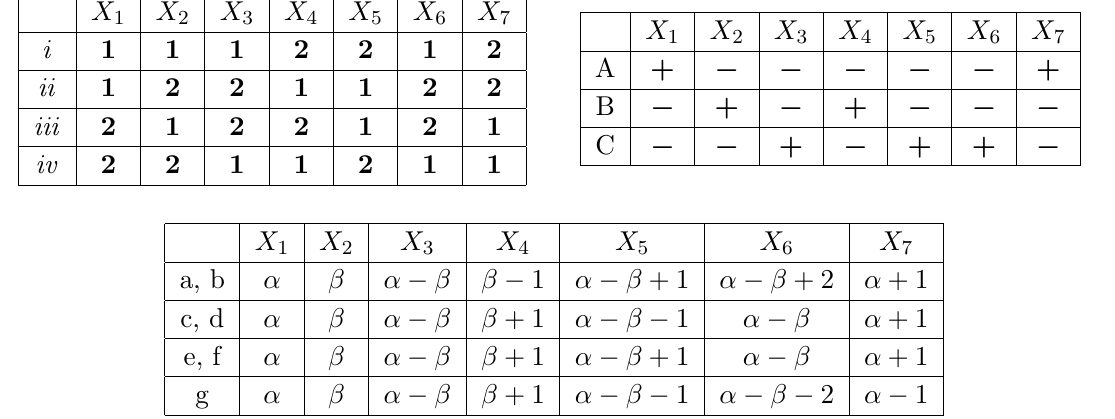
Table 9. SU ( 2 ) L (upper left), Z 2 (upper right) and U ( 1 ) Y (bottom) assignments for particles X 1 to X 7 of diagrams 2.a{2.g in (cid:12)gure